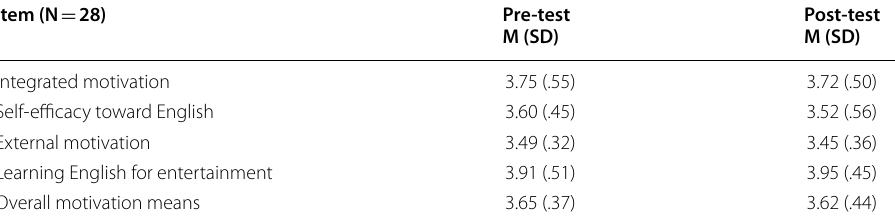
Table 8 L2 motivation rating scale (control group)